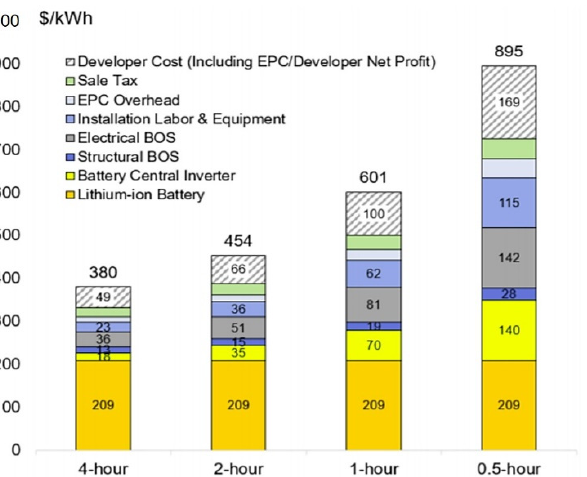
Figure A1. U.S. utility-scale Li-ion battery stand-alone storage costs for durations of 0.5–4 h (60 MW) 2018 [68]. In this figure, EPC and BOS represent Engineering and Procurement Cost and Balance of System respectively.